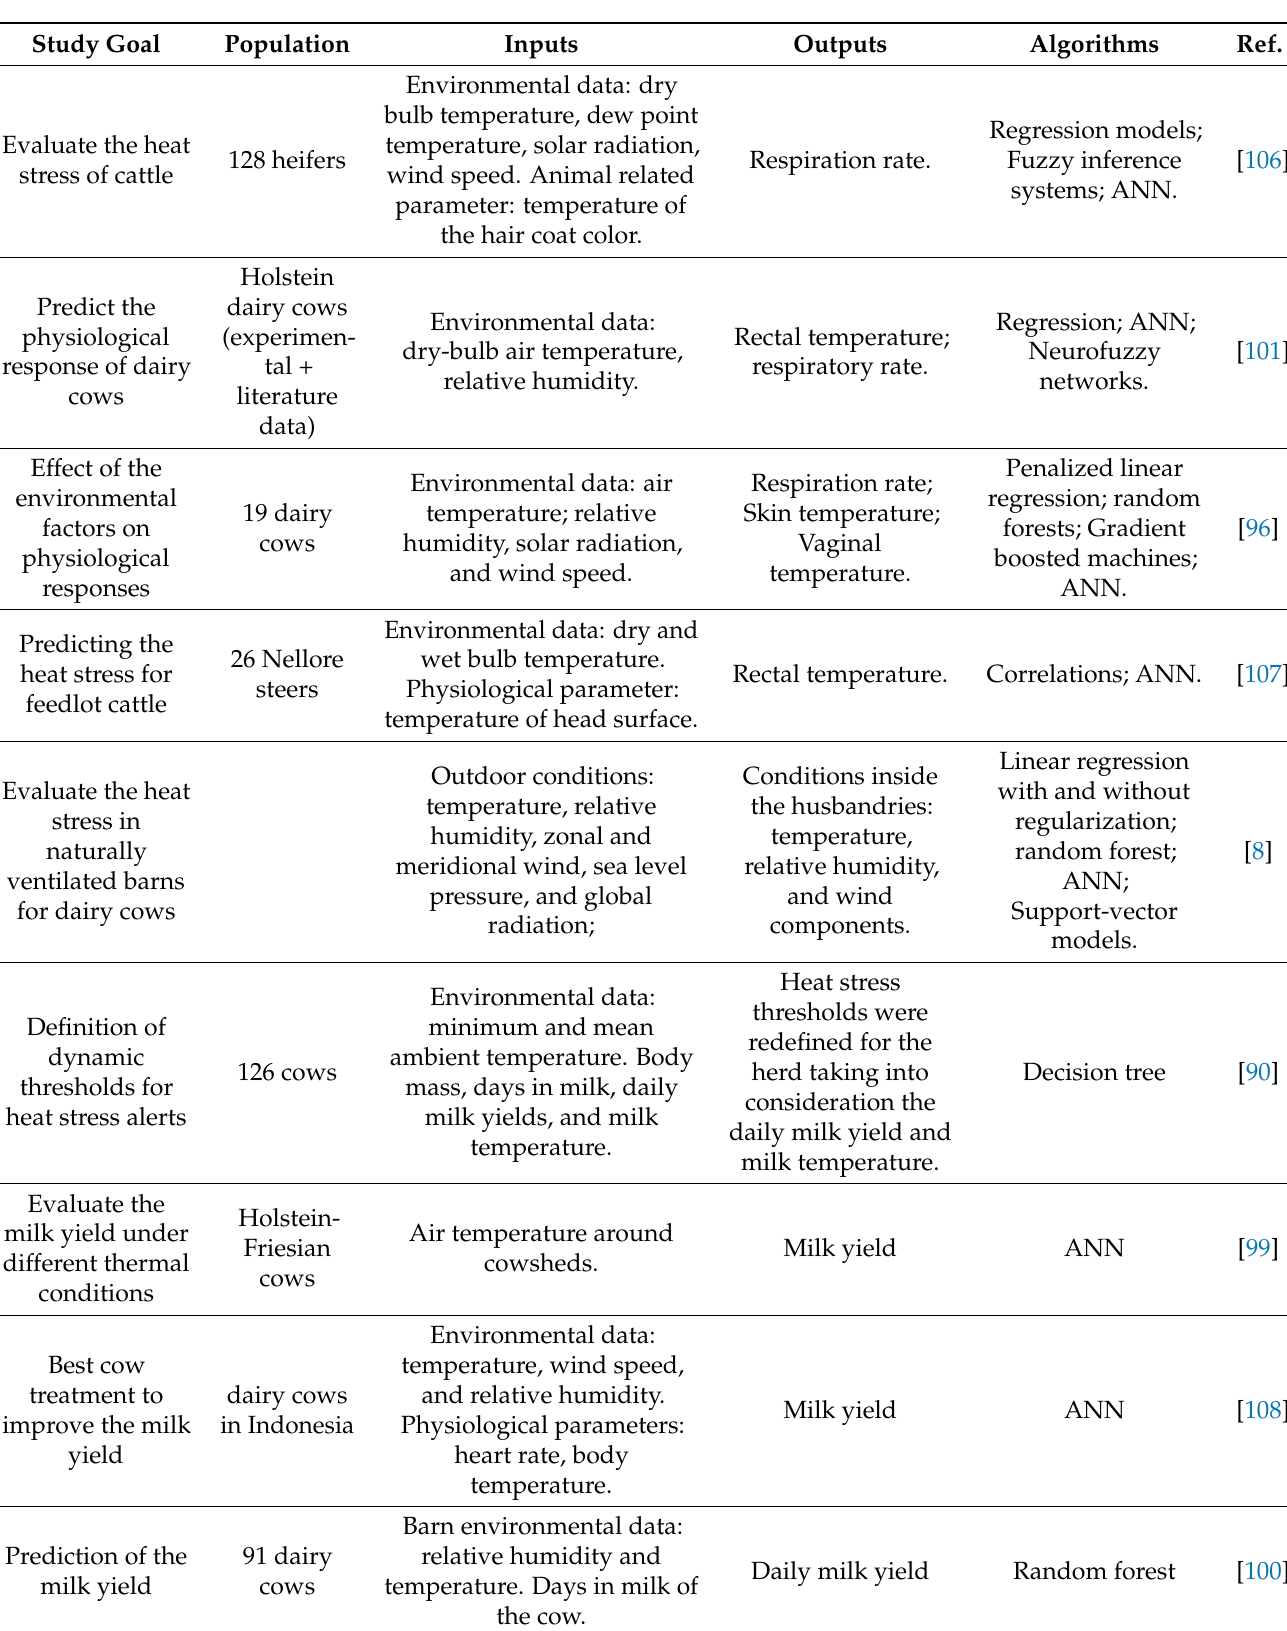
Table 2. Example of machine learning studies and the corresponding input and output